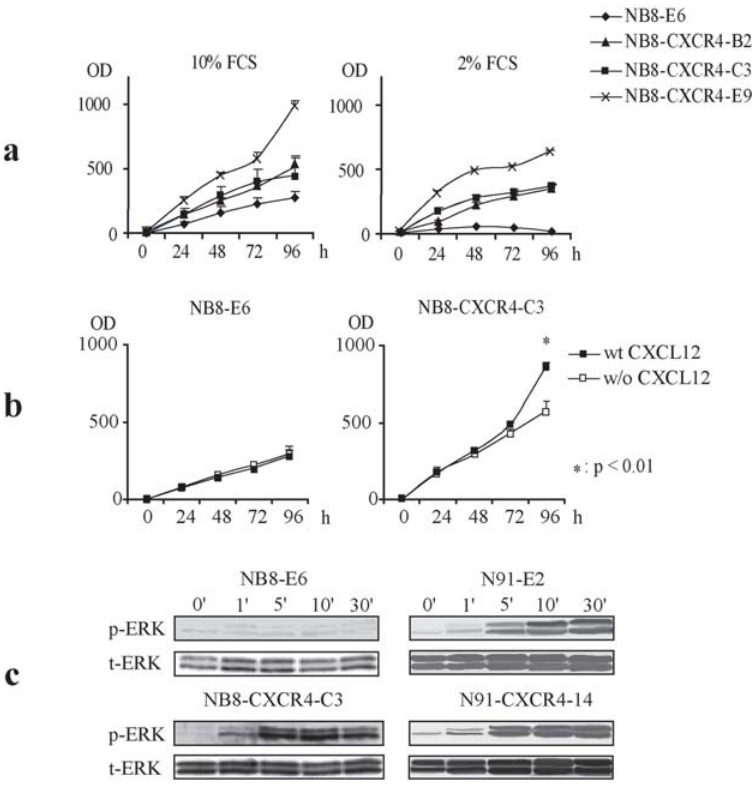
Figure 3. Effect of functional CXCR4 overexpression in NB cell lines. (a) I n vitro growth of NB8-E6, NB8-CXCR4-C3, -B2, and -E9 cells, in 10% (black squares) or 2% serum (open squares). (statistical analysis by two-way ANOVA and Bonferroni correction) A representative of three independent experiments is shown. (b) In vitro growth of NB8-E6 and NB8-CXCR4-C3 cells in the presence of 100 ng/ml CXCL12 (black squares) or in medium alone (open squares). (c) Western blot analysis of ERK1/2 phosphorylation in response to CXCL12 in CXCR4-transduced